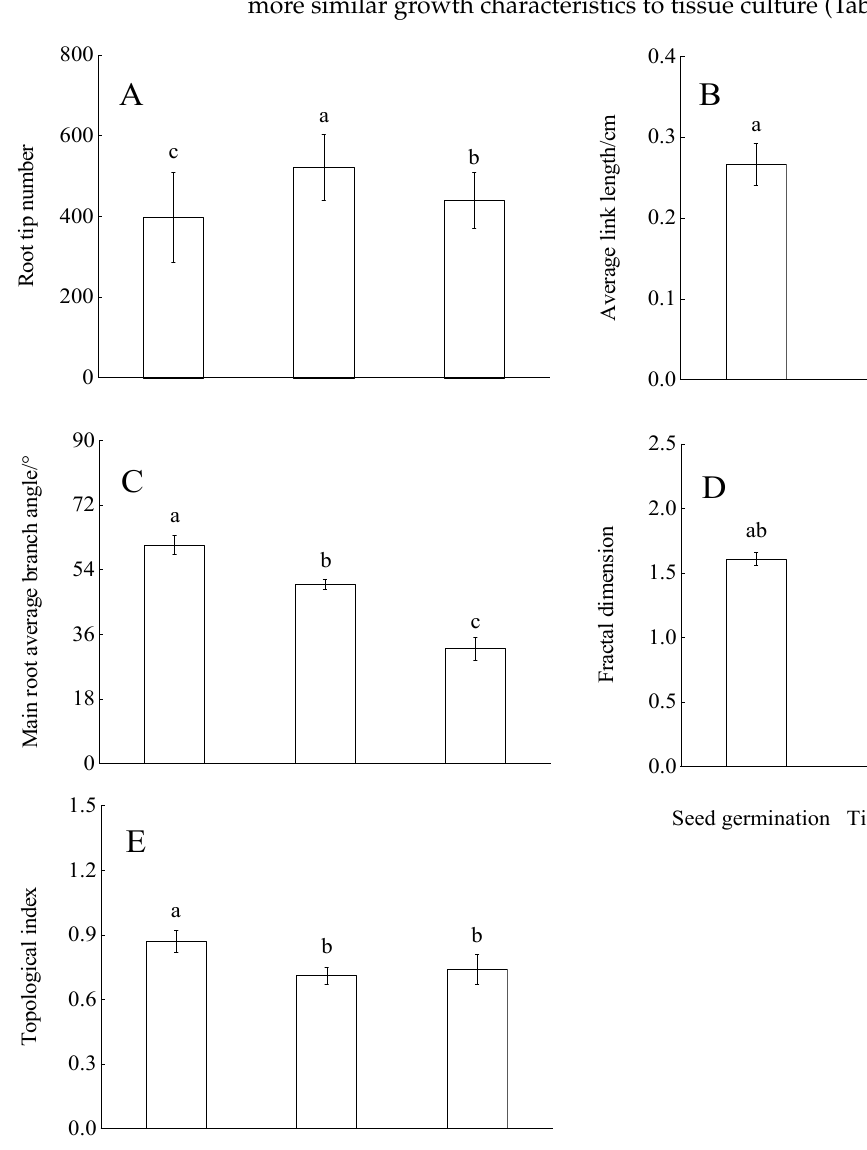
Figure 2. Differences in the root tip number ( A ), average link length ( B ), main root average branch angle ( C ), fractal dimension ( D ), and topological index ( E ) among different propagation methods. Bars (mean ± standard error) and the different lowercase letters indicate significant differences among different propagation methods at p < 0.05.